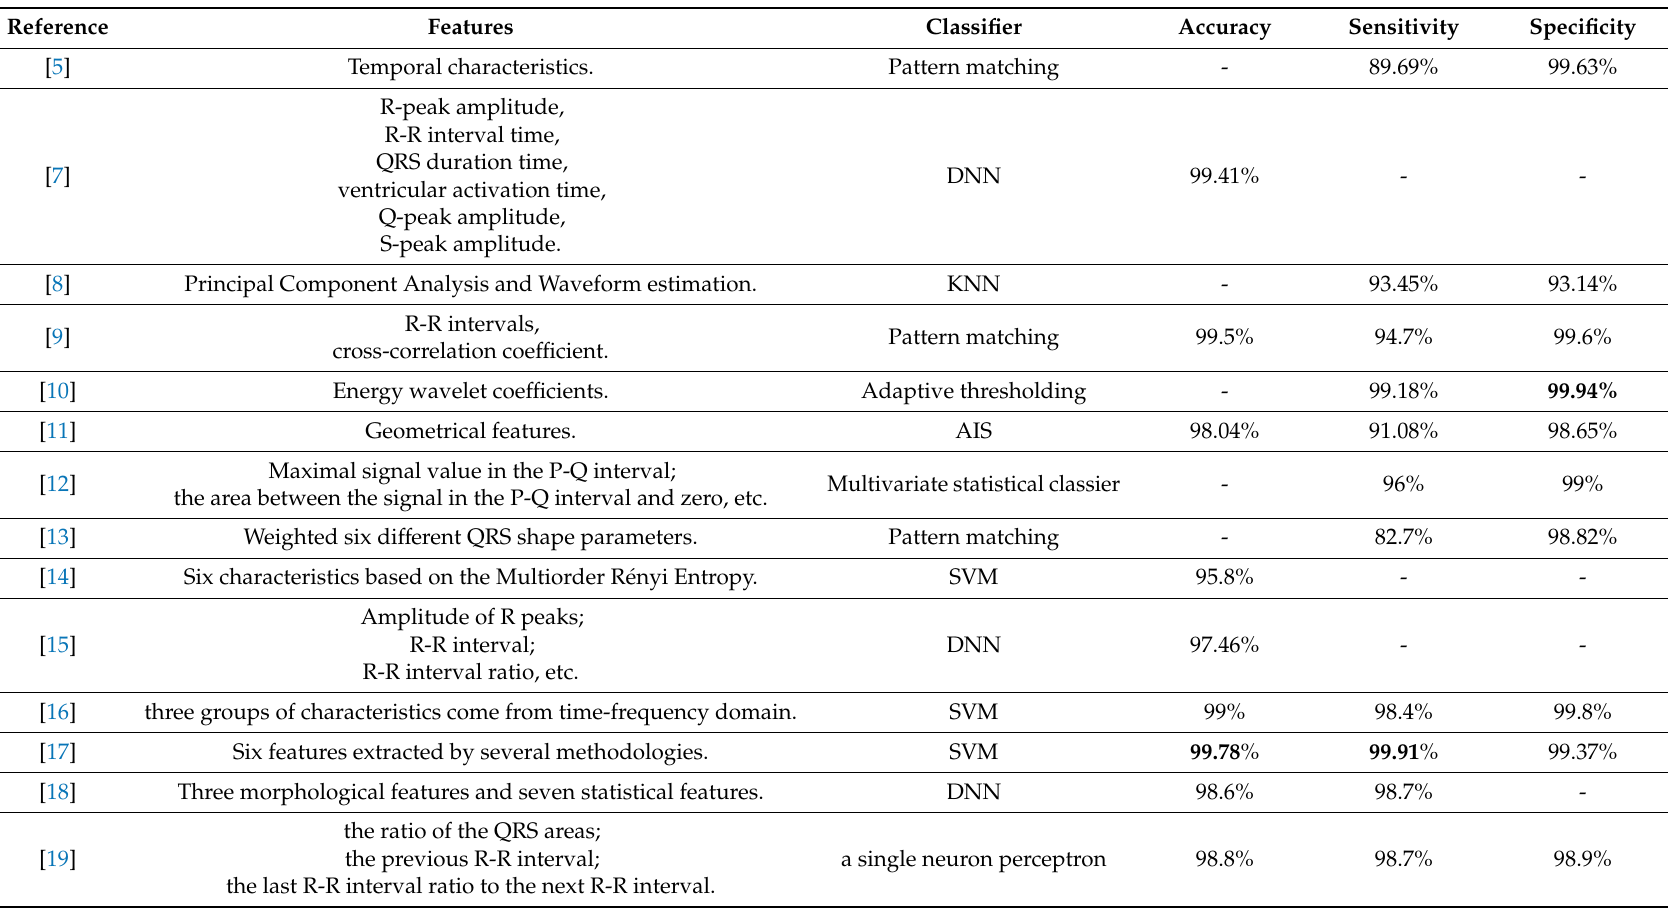
Table 1. Various algorithms for detecting premature ventricular contraction (PVC) in recent